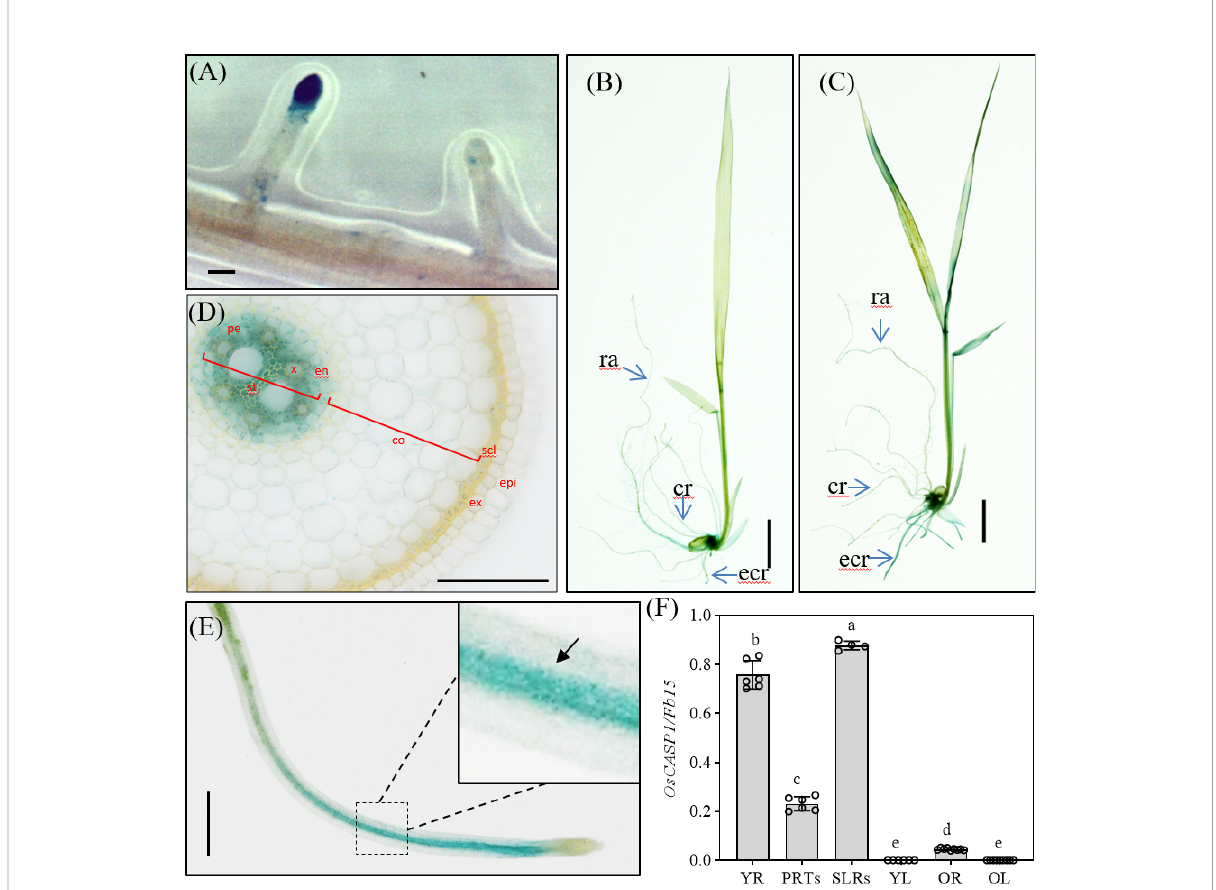
FIGURE 2 Localization of OsCASP1pro:OsCASP1-GUS expression. (A) GUS activity in SLR tip. (B) GUS staining of whole seedling plant grown in 1×Kimura B solution. (C) GUS staining of the plant treated with 100 mM NaCl for 3 hours. (D) Cross-section of a crown root (10 mm distal from the root tip) derived from a 10-d-old seedling treated with NaCl. (E) GUS activity in SLR treated with NaCl. (F) Expression levels of OsCASP1 in different tissues. YR, young root. PRTs, primary root tips. SLRs, small lateral roots. YL, young leaves. OR, old roots. OL, old leaves. Different letters denote signi fi cant differences in one-way ANOVA test (Tukey test p < 0.05) among different lines. Fb15 (Fiber protein 15) (Os02g0175800) was used as reference gene in the RT-qPCR analysis. Scale bars: (A, D, E) 100 m m; (B, C)